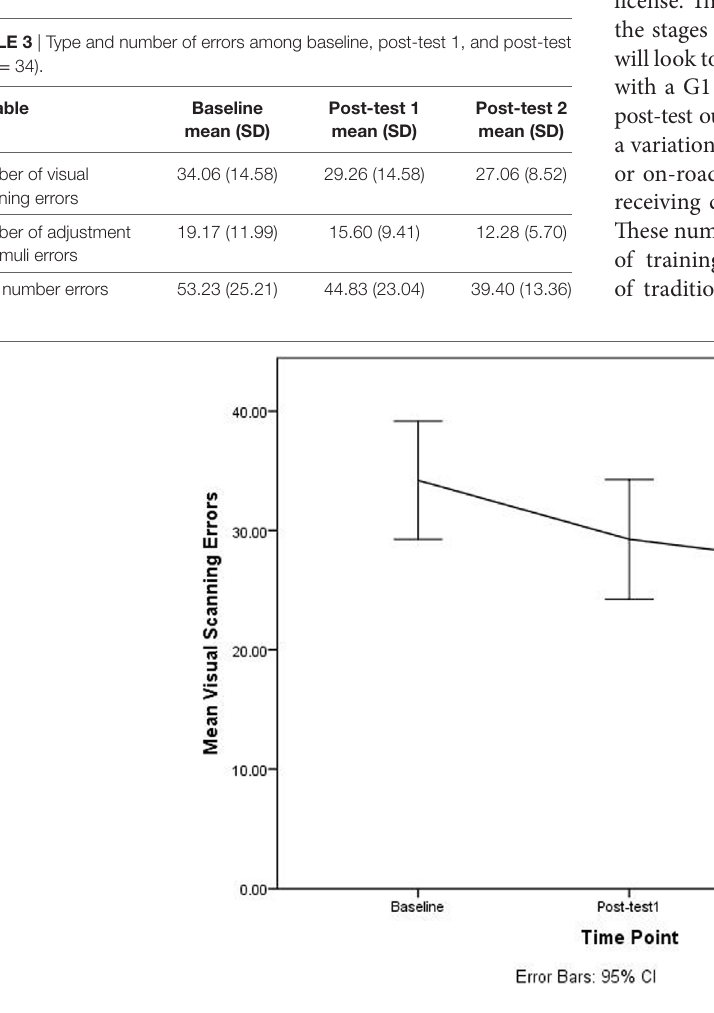
FigUre 2 | Number of visual scanning errors among baseline, post-test 1, and post-test 2.